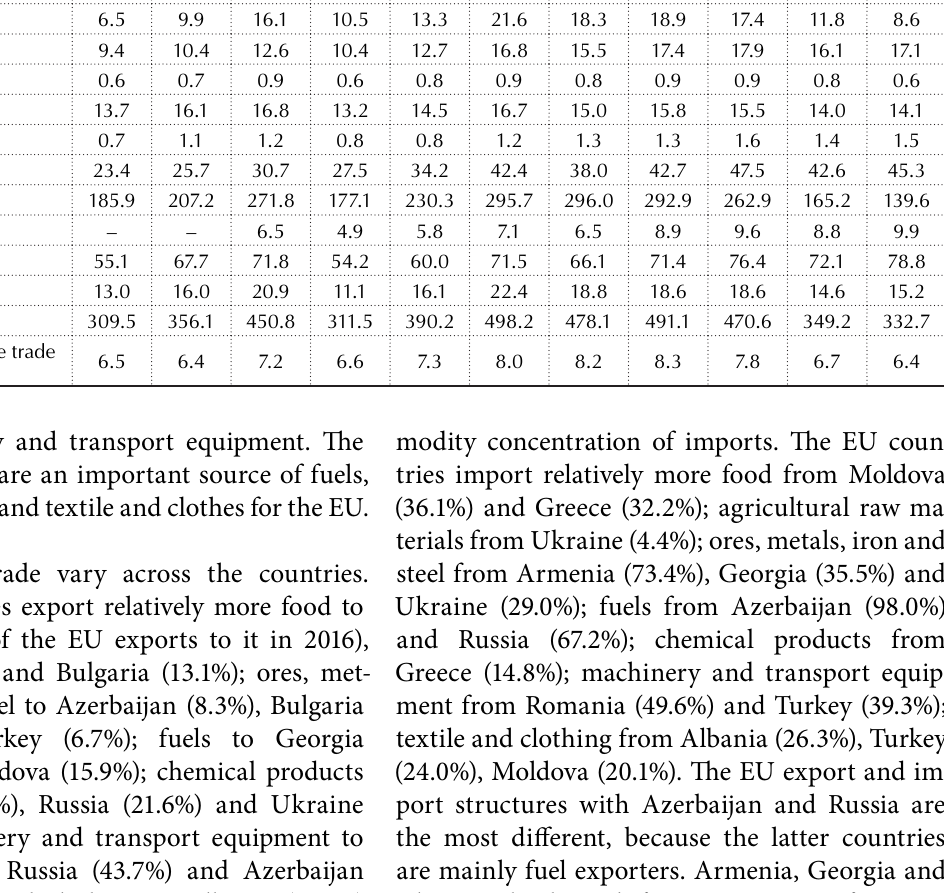
Table 3. Structure of the EU merchandise trade with the BSEC countries (2016)